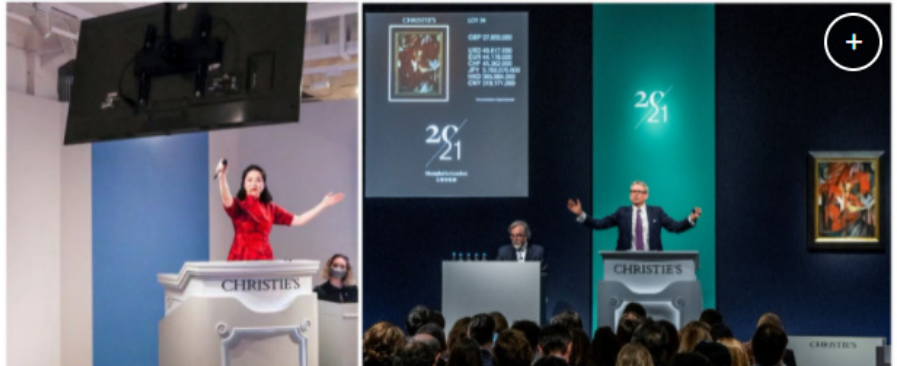
Figure 1. Christie’s Shanghai to London Evening Sale Series Realized USD 334 million (RMB 2 bil- lion), 1 March 2022. Image Courtesy: Christie’s. The auction, entitled “20/21 Century Shanghai to London”, started out in Christie’s new office and gallery space at Bund One Shanghai, front-loaded with works by young artists that were nearly fresh from the studio, before turning over to the British capital, where a Surrealist art evening sale was held.